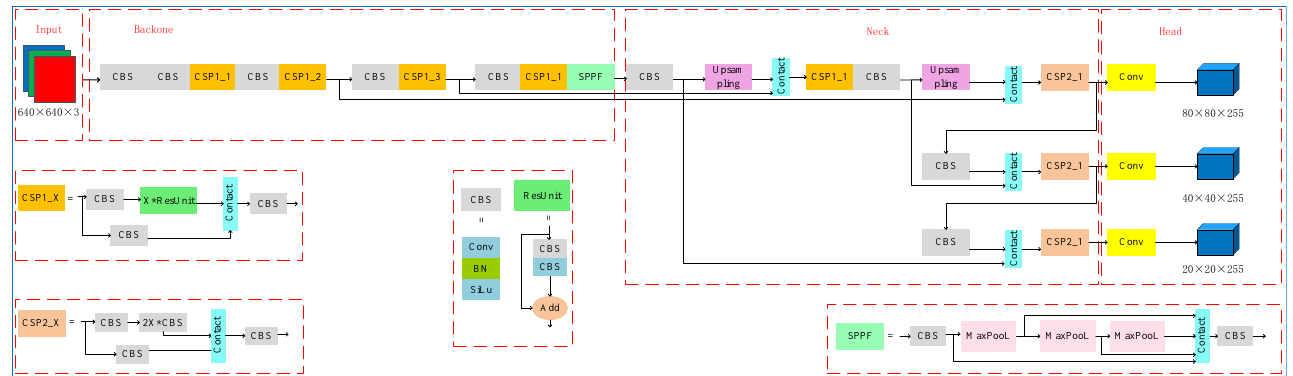
Figure 4. The architecture of